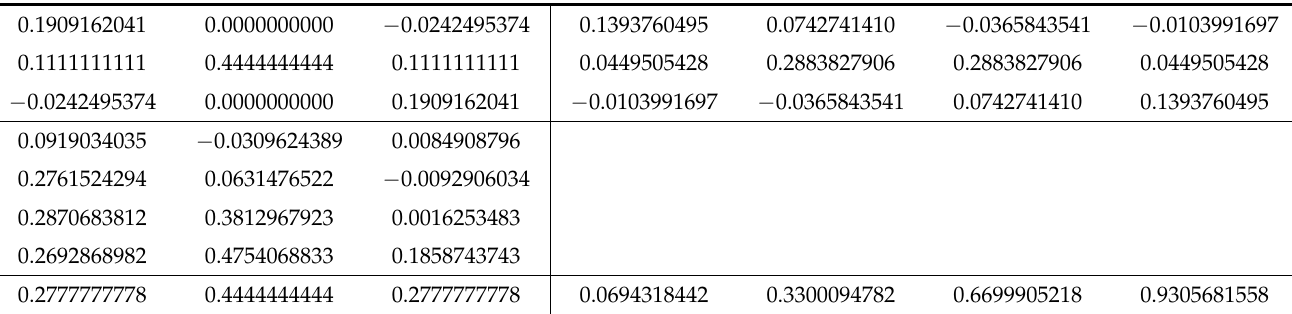
Table A14. G3|G4